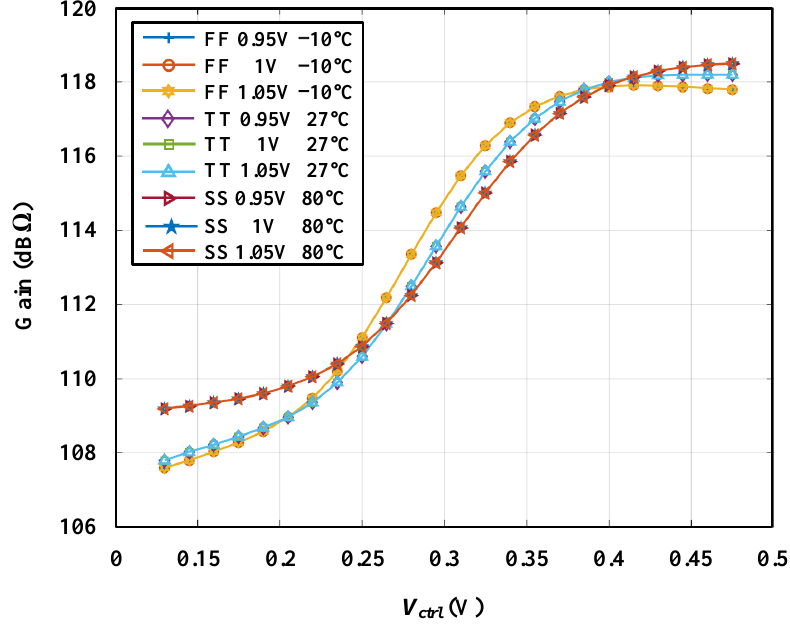
Figure 8. The TIA gain control under PVT